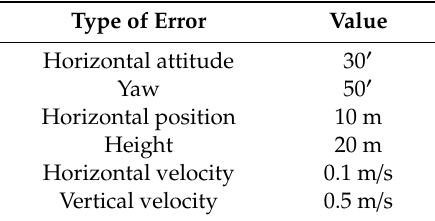
Table 4. Initial Error of UAV.